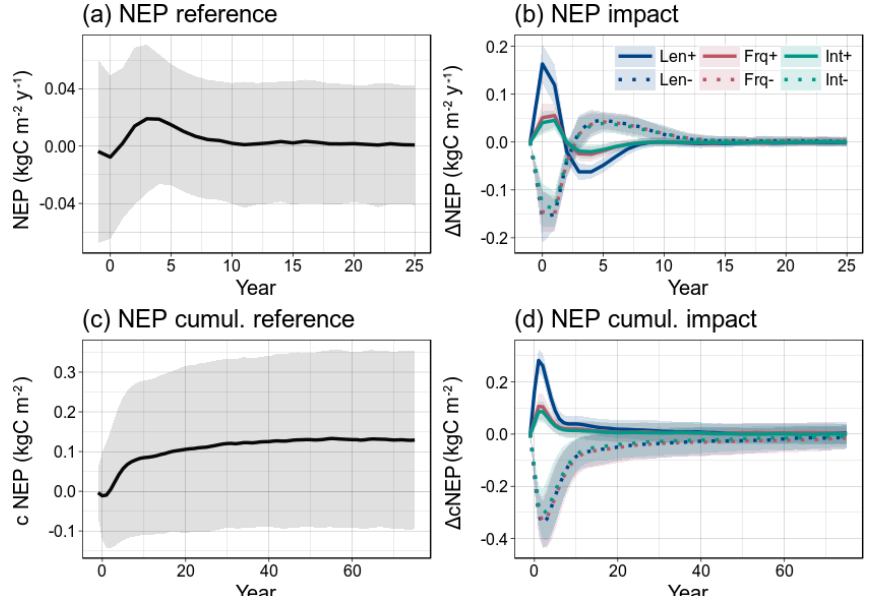
Figure 9. Impact of the different scenarios on the cumulative NEP at the Dahra site. (a) Average reference yearly NEP over a period of 25 years after the disturbance. (b) Impact of the disturbances on yearly NEP. (c) Average reference cumulative NEP (cNEP) on a longer timescale (70 years). (d) Impact of the disturbances on the cumulative NEP ( (cid:49) cNEP). The year prior to the perturbations is used as a starting point for the cumulative sum. Shaded areas indicate variability of the model runs over all ensemble members ( ± 1 σ ).